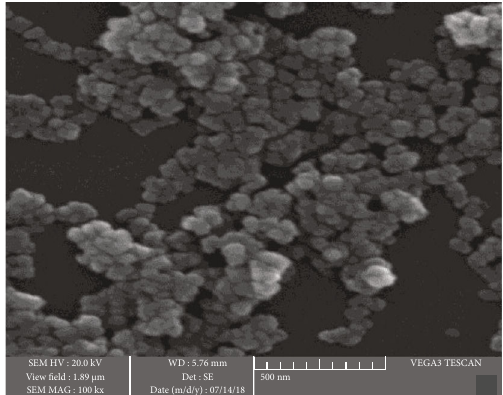
Figure 3: SEM images of Fe